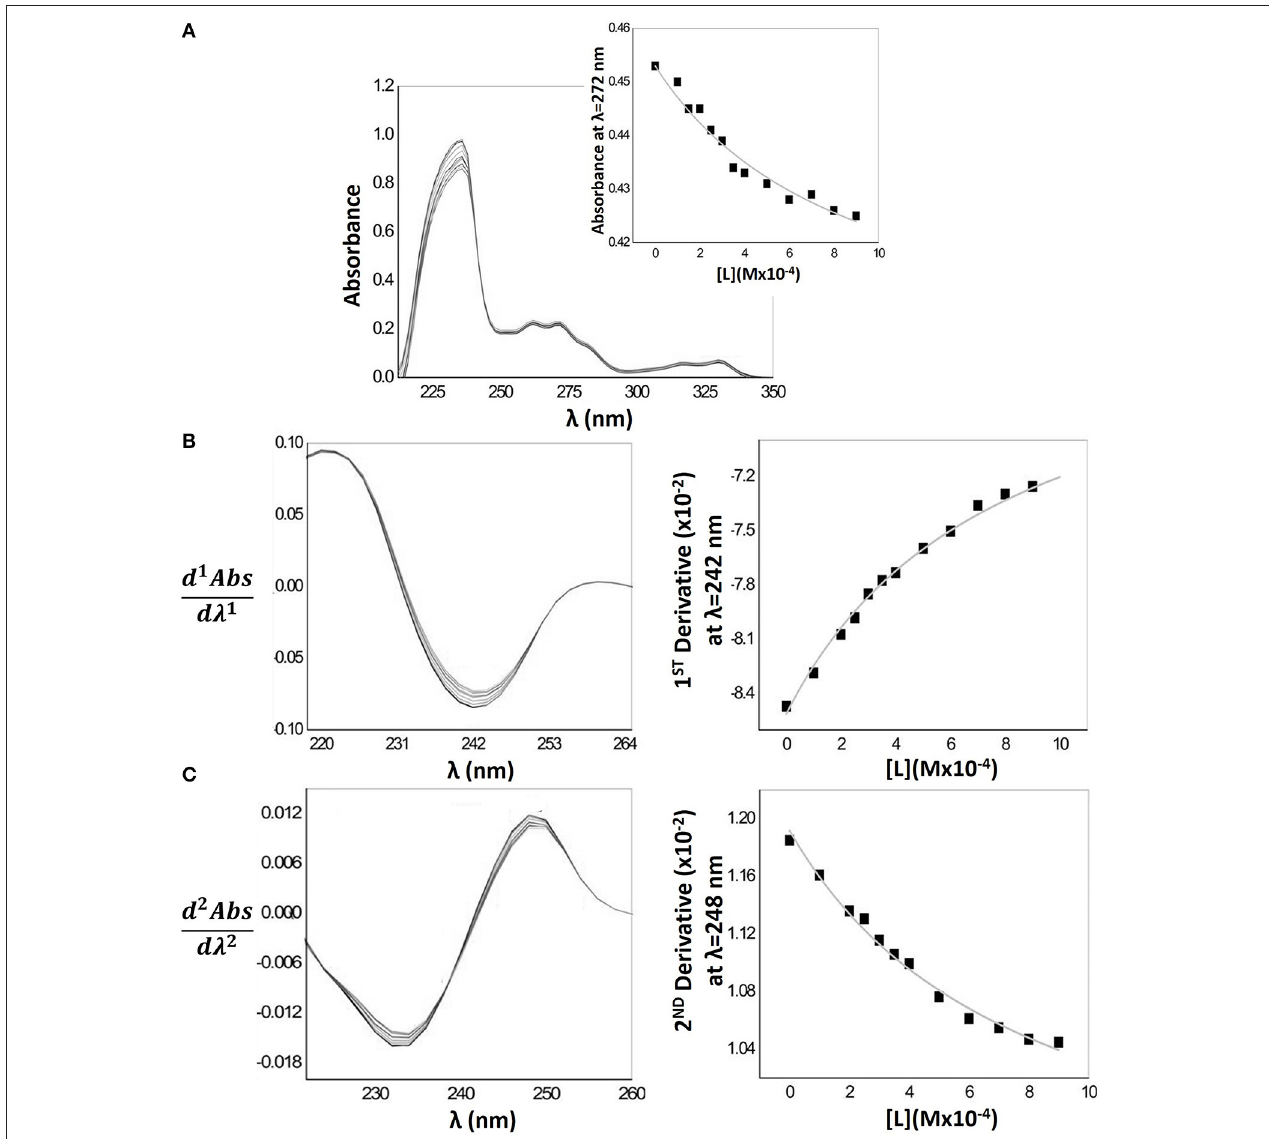
FIGURE 3 | Schematic representation of mathematical treatment (fittings according Equations 1, 2) applied to Naproxen experimental absorption spectra with increasing concentrations of HDPC micelles (0–900 µ M) in Hepes buffer pH = 7.4 and I = 0.1 M. (A) Naproxen absorption spectra including as an inset the plot of drug absorbance values at λ max = 272 as a function of lipid concentration and the respective fitting by non-linear regression method. (B) First derivative of the Naproxen absorption spectra and the correspondent fitting at λ max = 242nm. (C) Second derivative of the Naproxen absorption spectra and the correspondent fitting at λ max =